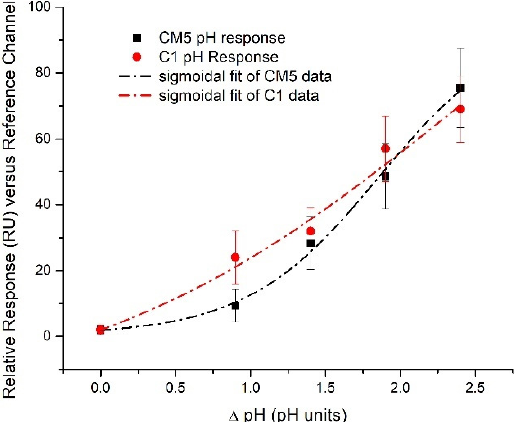
Figure 7. SPR response dependence on pH step changes (towards acidic domain) of the same Au- DCFs covalently immobilized on C1 (red) and CM5 (black) surfaces. Data is referenced versus the blank channel (without the Au-DCF) on each type of